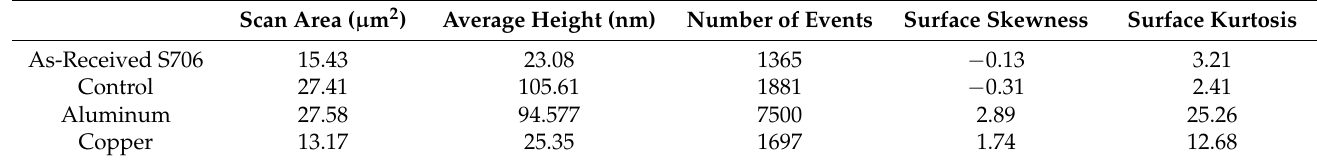
Table 4. Atomic-Force Microscopy (AFM) surface profile